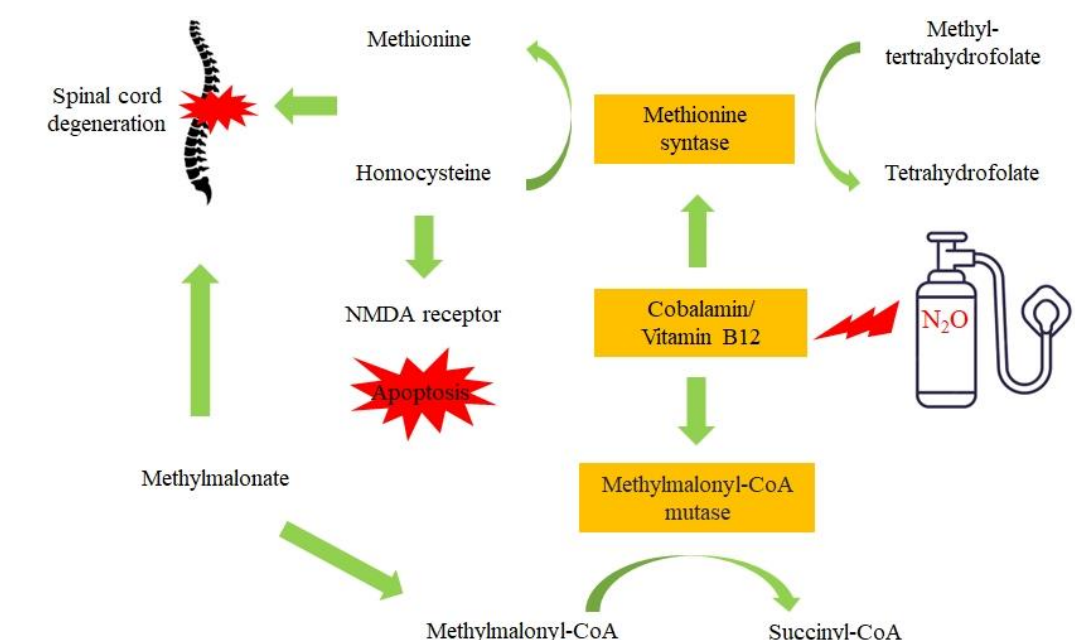
Figure 1. The main mechanisms involved in N 2 O-induced neurotoxicity. Central toxicity arises from the deactivation of the cobalt-ion at the cobalamin (vitamin B12) molecule, which leads to a cascade of neurotoxic effects.